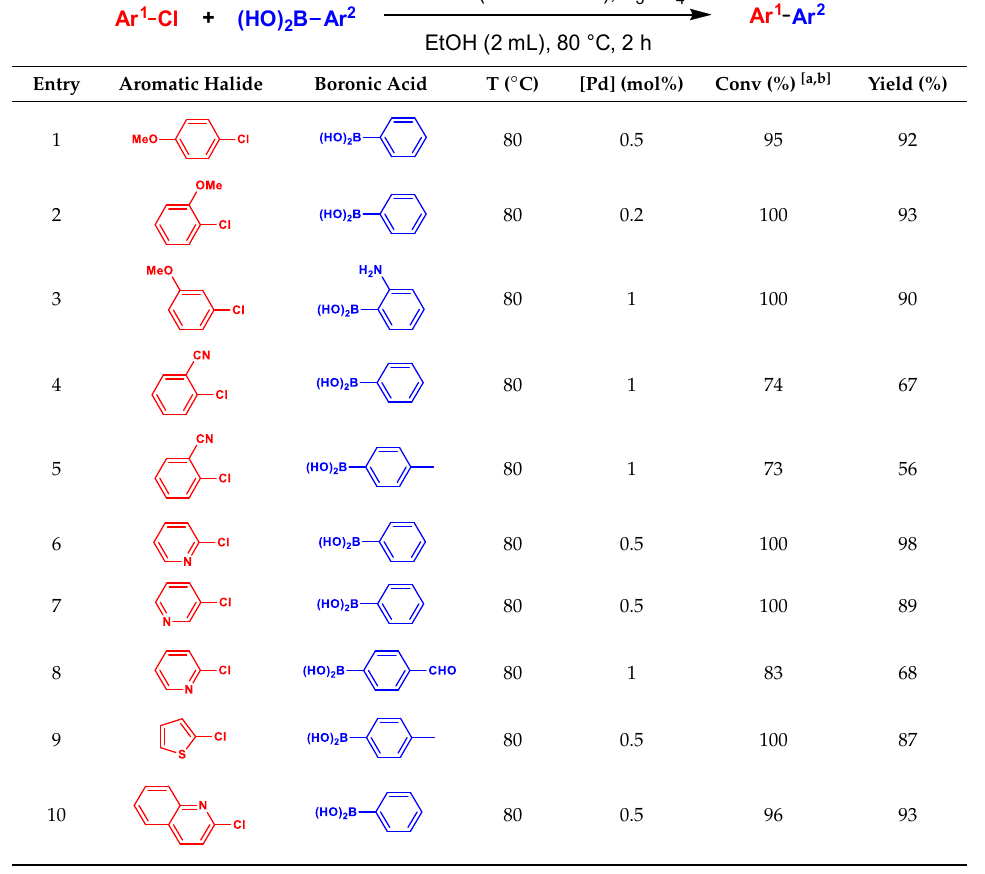
Figure 5. Conversion/time plots for various catalysts. 4-chlorotoluene (1 equiv., 1 M), phenylboronic Figure 5. Conversion / time plots for various catalysts. 4-chlorotoluene (1 equiv., 1 M), phenylboronic acid (1.5 equiv.), K 3 PO 4 (2 equiv.), [Pd] = 0.5 mol%, 80 °C, reaction performed under argon Table 4. Scope of the Suzuki cross-coupling reaction catalyzed by Calx-IPr. Table 4. Scope of the Suzuki cross-coupling reaction catalyzed by Calx-IPr. acid (1.5 equiv.), K 3 PO 4 (2 equiv.), [Pd] = 0.5 mol%, 80 ◦ C, reaction performed under argon atmosphere. Table 4. Scope of the Suzuki cross-coupling reaction catalyzed by Calx-IPr. Table 4. Scope of the Suzuki cross-coupling reaction catalyzed by Calx-IPr. Table 4. Scope of the Suzuki cross-coupling reaction catalyzed by Calx-IPr. Table 4. Scope of the Suzuki cross-coupling reaction catalyzed by Calx-IPr. Table 4. Scope of the Suzuki cross-coupling reaction catalyzed by Calx-IPr. Table 4. Scope of the Suzuki cross-coupling reaction catalyzed by Calx-IPr. Entry Aromatic Halide Entry Aromatic Halide Entry Aromatic Halide Table 4. Scope of the Suzuki cross-coupling reaction catalyzed by Calx-IPr.